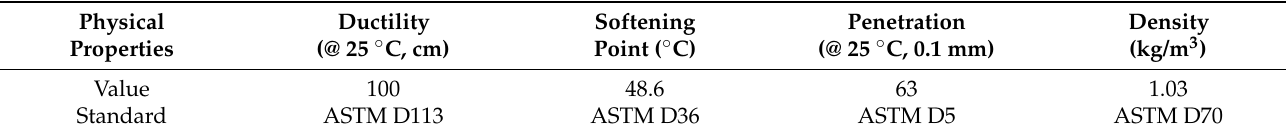
Table 2. Specification of the penetration grade bitumen 50/70.